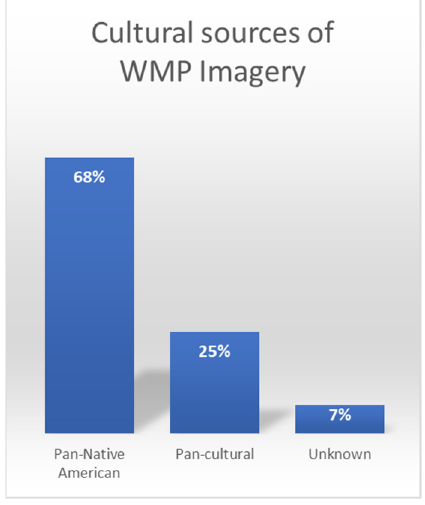
Figure 4. Cultural Sources of WMP Imagery.